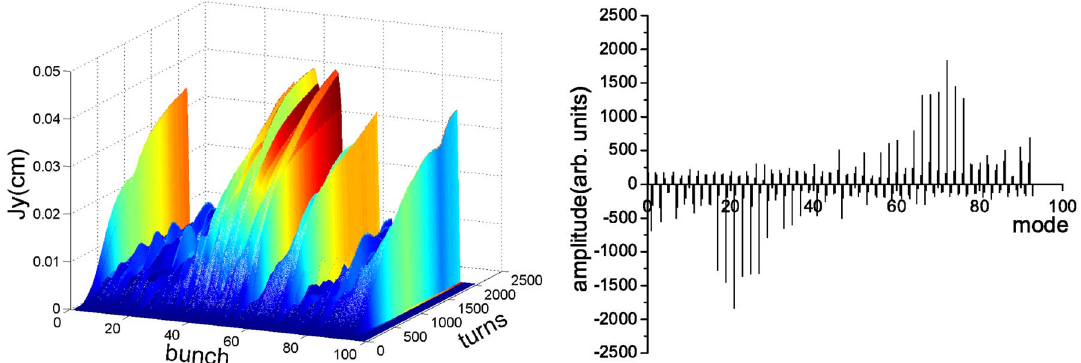
FIG. 18. (Color) Growth behavior of coupled-bunch oscillation and the mode distribution.